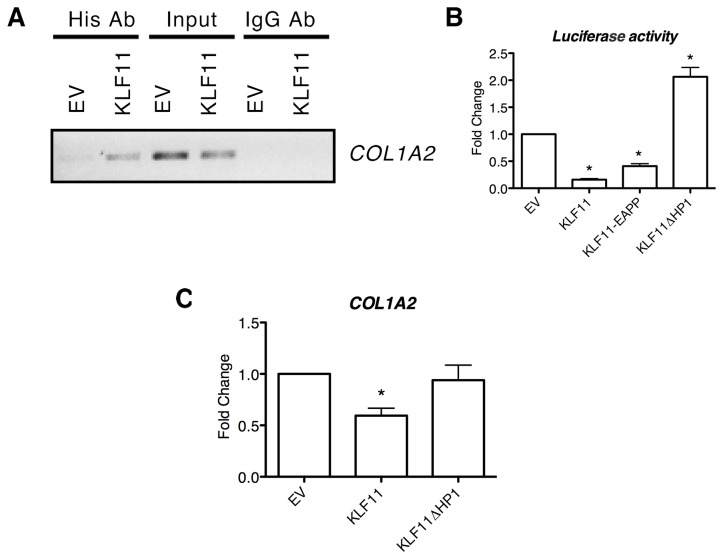
Collagen 1 is directly repressed by KLF11 in mesenchymal cells coupled to the HP1-HMT pathway.(A) To illustrate that KLF11 was a direct regulator of the collagen I promoter, chromatin immunoprecipitation was performed on LX2 cells transduced with empty vector or KLF11. Immunoprecipitation of KLF11 displayed amplification of the collagen 1a2 promoter by PCR, thus verifying the direct binding of KLF11 to the promoter of collagen1a2. Input controls for empty vector and KLF11 are included to ensure equal volume of precipitated DNA as well as the results of amplification from immunoprecipitates using a non-specific IgG antibody. (B) Further evidence that collagen is a direct target of the sequence specific transcription factor KLF11 was observed in luciferase assays. Sections of the collagen 1a2 promoter containing GC consensus sequences were cloned upstream of a luciferase reporter. The reporter gene was significantly repressed upon overexpression of KLF11 in LX2 cells (84 ± 1.94% compared to empty vector, p<0.05). Examination of the effect of overexpression of KLF11-EAPP mutant reveals only a slight change in the repression of the collagen I promoter (41 ± 4.5% repression compared to empty vector, p<0.05). However, overexpression of the KLF11ΔHP1 mutant lead to completion de-repression of the collagen I promoter (206 ± 17% compared to empty vector, p<0.05), indicating that the repression of the gene occurs through the HP1-HMT chromatin remodeling pathway. (C) PCR of collagen 1a2 expression in LX2 cells transduced with empty vector, KLF11, or KLF11ΔHP1 demonstrate that expression of the gene is repressed in the presence of KLF11 (0.59 ± 0.11 fold compared to empty vector) but depressed in the presence of the inactivating KLF11ΔHP1 mutant (0.92 ± 0.14 fold compared to empty vector).